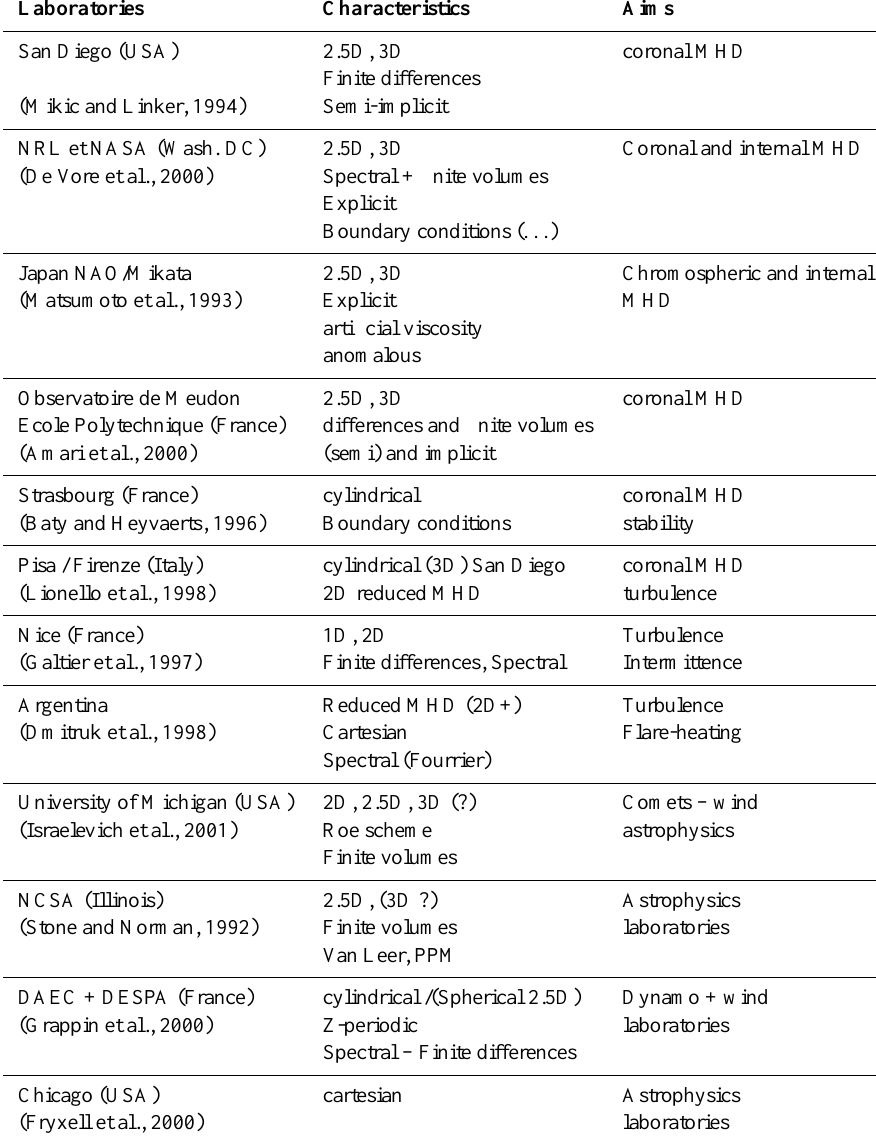
Table 1. A synthesis of MHD codes for the evolution of the solar magnetic configurations